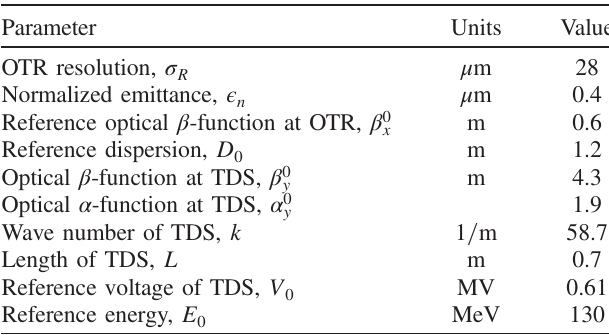
TABLE I. Simulation